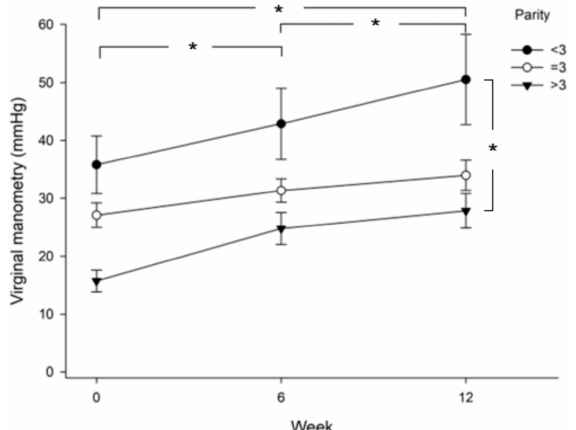
Figure 3. Comparison of vaginal pressure between groups of parity >3, =3, or <3. Significant differences are shown between the three groups at week 6 vs. baseline ( p = 0.000), week 12 vs. baseline ( p = 0.000), and week 12 vs. week 6 ( p = 0.002). Vaginal pressure in the parity >3 group is significantly lower than that in the parity <3 group (least significant difference test, p = 0.003); *, p <